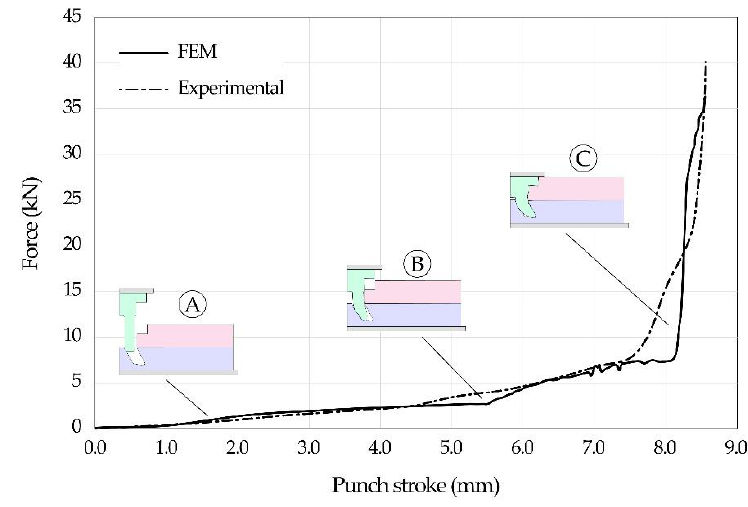
Figure 9. Experimental and finite element predicted evolution of the riveting force with punch stroke for a counterbored head rivet with α = 30 ◦ , d p = 4 mm. The mesh details are taken from each of the three deformation stages.